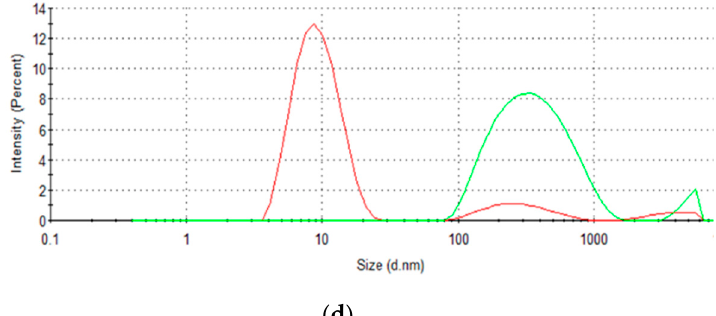
Figure 3. Effect of the protein concentration on the particle size distribution in ( a ) 0.5 mg·mL − 1 (red line) and 1.0 mg·mL − 1 (green line) BSA solutions, and ( b ) 1.5 mg·mL − 1 (red line), 3 mg·mL − 1 (blue line), 5 mg·mL − 1 (green line), and 10 mg·mL − 1 (black line) BSA solutions without recirculation through the amine-functionalized monolith column. Effect of contact time of the protein solution with the monolith on the particle size distribution when using ( c ) 1 mg·mL − 1 and ( d ) 5 mg·mL − 1 BSA solutions in static conditions (red line) and recirculated through the monolith column for 24 h (green line).